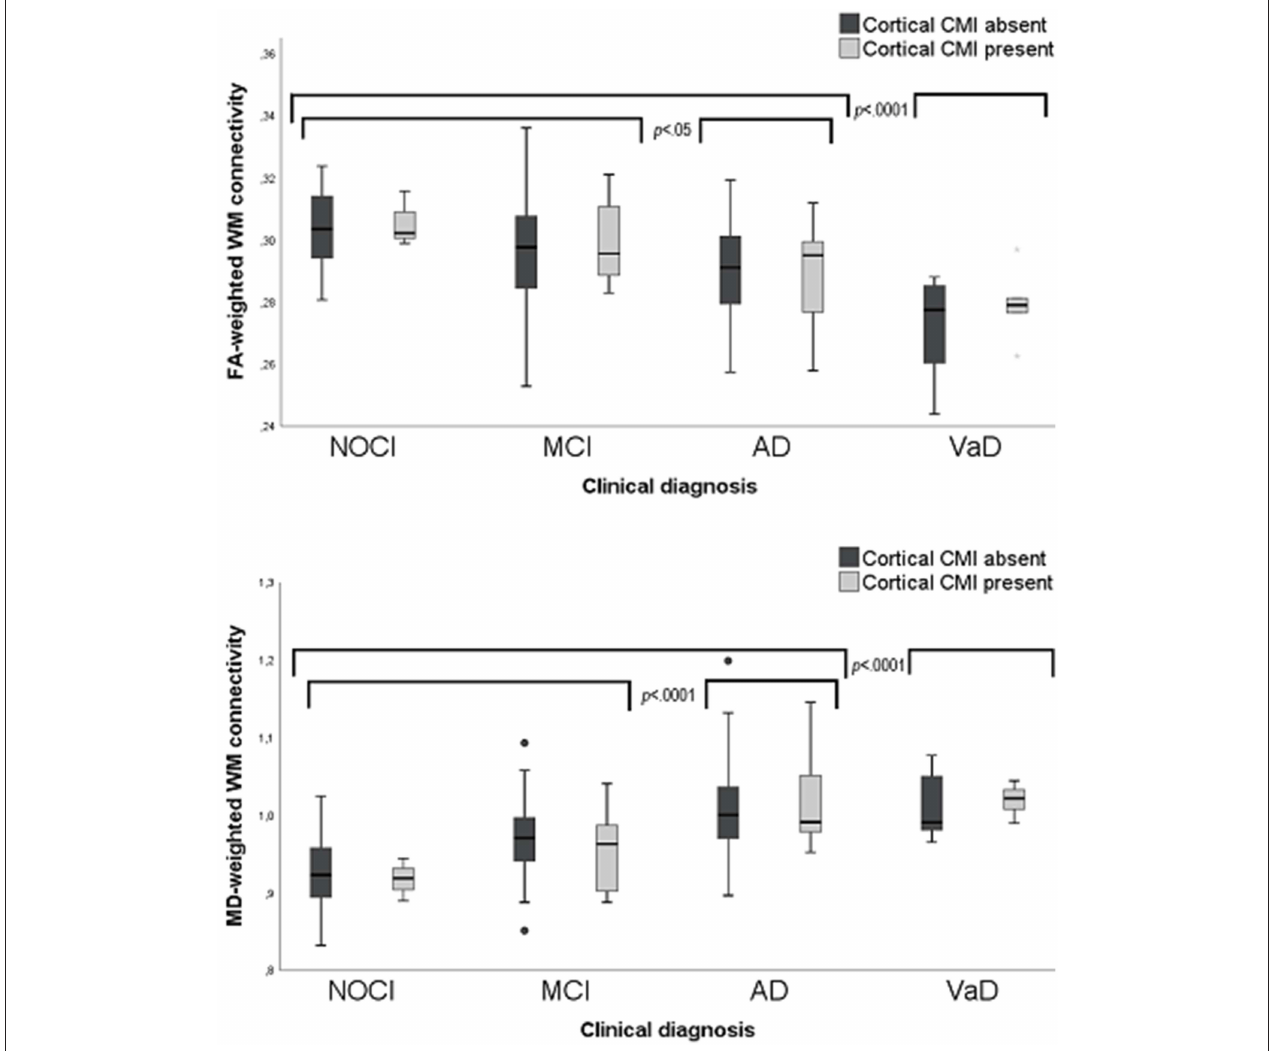
FIGURE 3 | Box plots of FA-(upper) and MD-(lower) weighted WM connectivity between patients with and without cortical CMIs (labels) clinical diagnosis (X-axis). MD values × 10 − 3 mm 2 /s. CMI, Cortical microinfarct; NOCI, No objective cognitive impairment; MCI, Mild cognitive impairment; AD, Alzheimer’s disease; VaD, Vascular